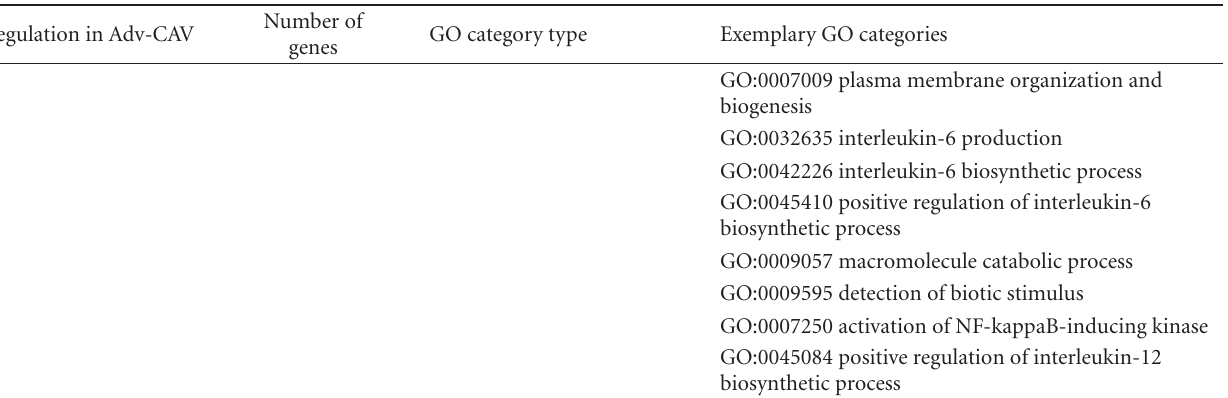
Adv-CAV: advanced cardiac allograft vasculopathy.